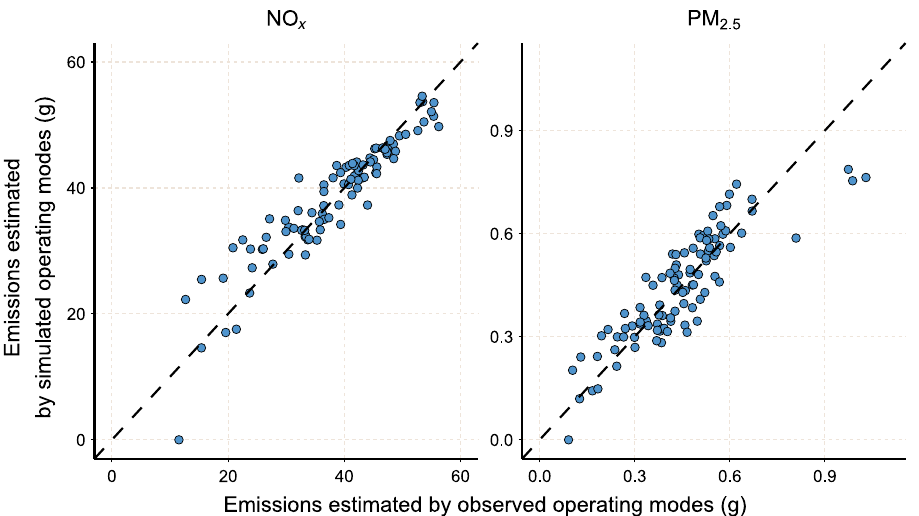
Fig. 8 The correlations of the estimated NO x and PM 2.5 emissions of HDT trajectories between the observed and simulated operating modes. Each point represents that a HDT trajectory. The slops of the dashed lines are 1. *Source data are provided as a Source Data fi le.